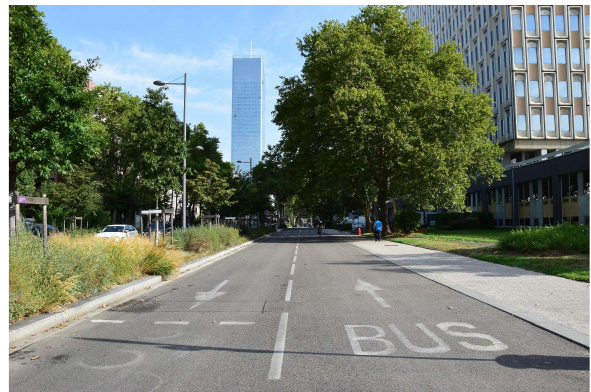
Figure 2. Garibaldi Street, deployment area of the tree monitoring sensors.